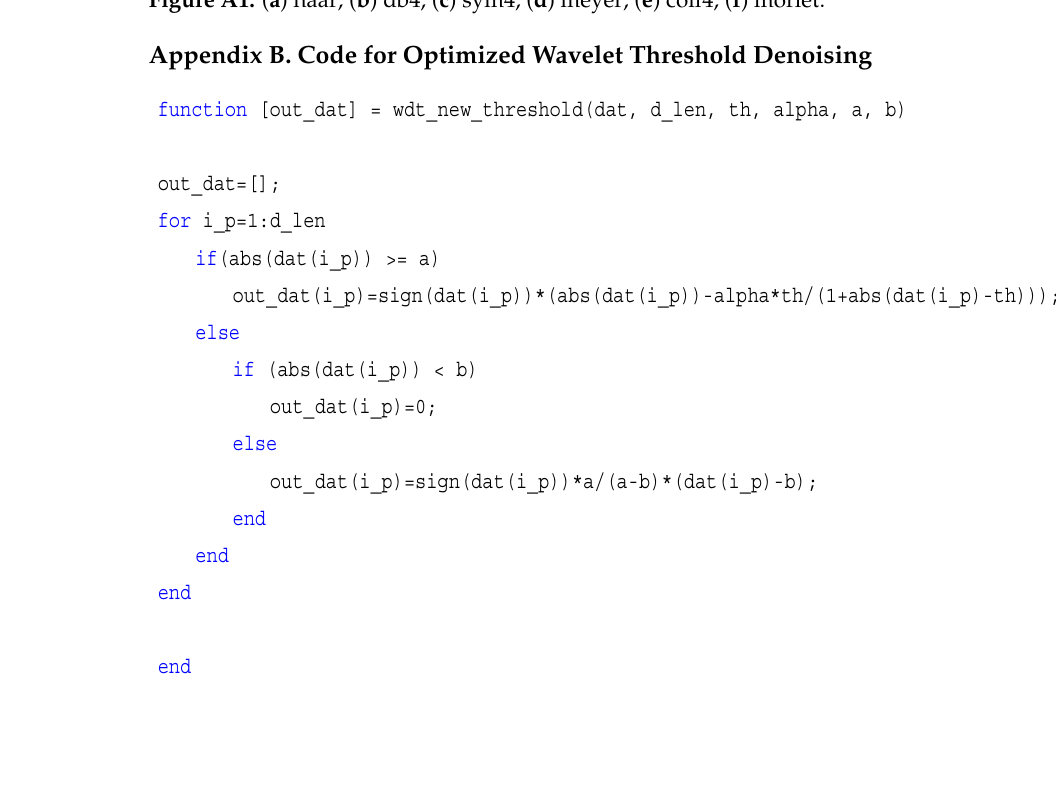
Figure A1. ( a ) haar; ( b ) db4; ( c ) sym4; ( d ) meyer; ( e ) coif4; ( f ) morlet.